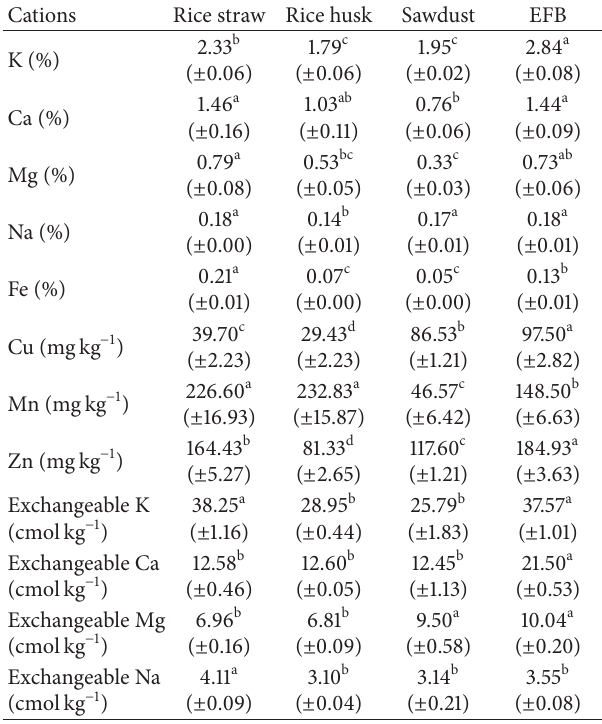
Different alphabets within a row indicate significant difference between means using Tukey’s test at 𝑃 ≤ 0.05 . ( ) values in parenthesis represent standard error of the